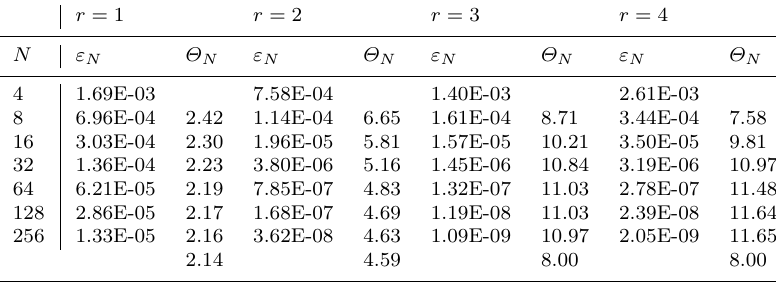
Table 2. Numerical results for problem (5.6) – (5.7) with m = 2.